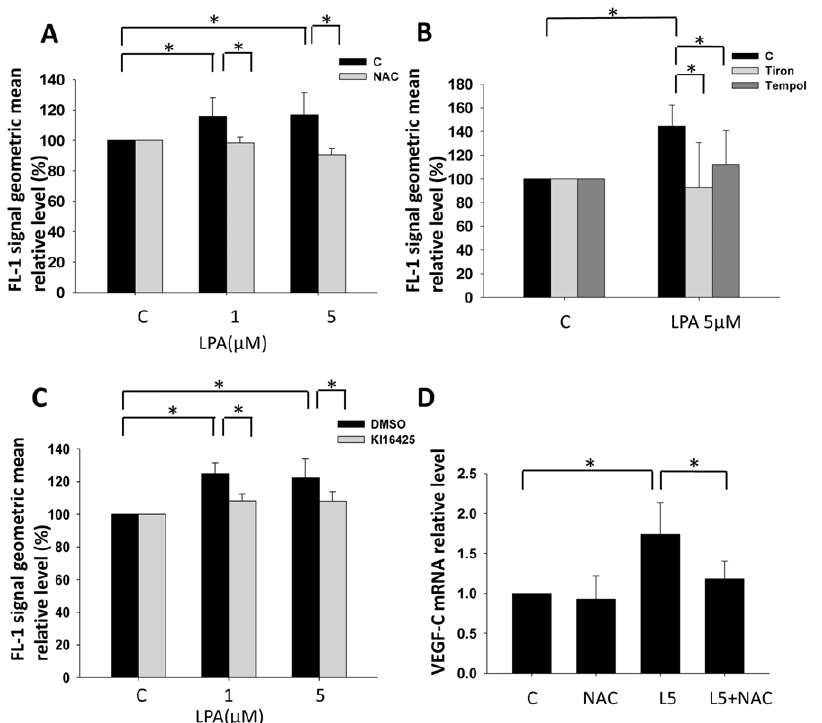
Figure 3. The role of reactive oxygen species (ROS) in LPA 1/3 -enhanced vascular endothelial growth factor (VEGF)-C expression. PC- 3 cells were pretreated with 2.5 m M DCFDA for 10 min. Followed by 10 min of LPA stimulation, cells were trypsinized and analyzed by flow cytometry. (A) 10 mM NAC, (B) 1 mM Tiron and 1 mM Tempol were used to treat cell before LPA stimulation. (C) Ki16425 (10 m M) was used to block the LPA 1/3 signal pathway before LPA stimulation. (D) PC-3 cells were treated with 10 mM NAC, an antioxidant followed by 5 m M LPA for 2 h (L5: 5 m M LPA). The relative VEGF-C mRNA expression was measured. mRNA was reverse-transcribed and analyzed by a real-time PCR. The relative level of VEGF-C normalized to GAPDH is shown. * Statistically different compared to the vehicle-incubated sample treated with LPA (* p , 0.05).